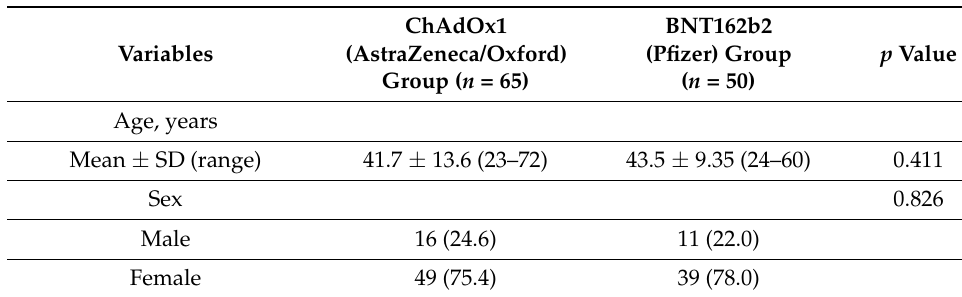
Table 1. Demographics of participants.